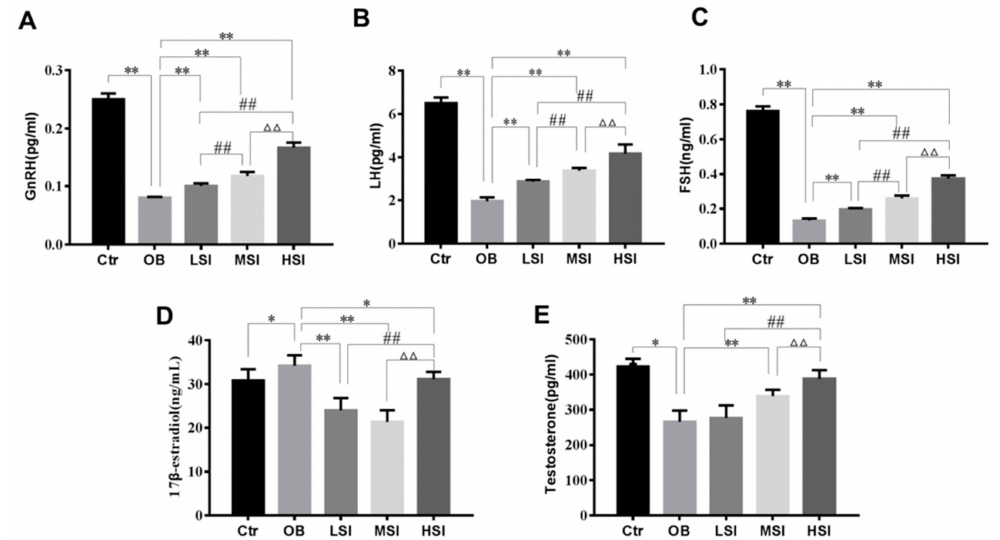
Figure 2. E ff ects of SIF on plasma reproductive hormone. Quantification shows ( A ) plasma gonadotropin-releasing hormone (GnRH) levels, ( B ) plasma luteinizing hormone (LH) levels, ( C ) plasma follicle-stimulating hormone (FSH) levels, ( D ) plasma E2 levels and ( E ) plasma T levels. Bars represent the mean ± SD, * p < 0.05, ** p < 0.01 vs. OB; # p < 0.05, ## p < 0.01 vs. LSI; ∆ p < 0.05, ∆∆ p < 0.05 vs. MSI, one-way ANOVA analysis and LSD